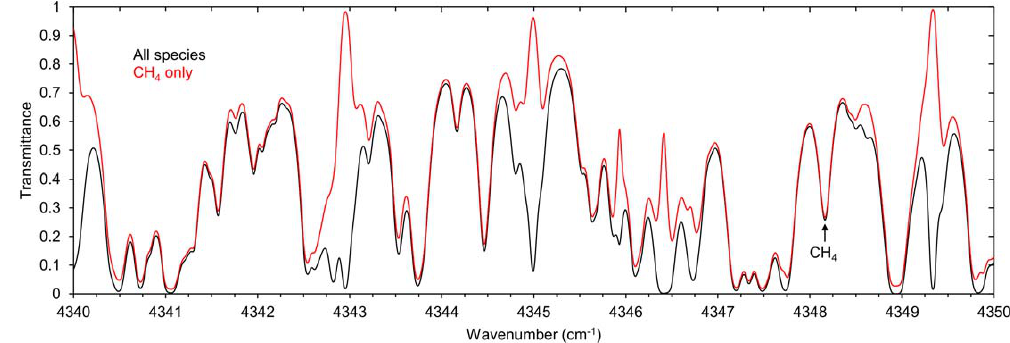
Fig. A2. Calculated spectrum of the CH 4 (2.3µm) signal region. This region is covered by the IR laser for CH 4 measurements (L4). CH 4 only – calculated for CH 4 only. All species – calculated including all relevant atmospheric species; almost all extra absorption is due to H 2 O. The label indicates the target absorption line position (cf. Table A1). Depending on actual frequency scan ranges, other spectral sections can be used. For conditions see Appendix A6.